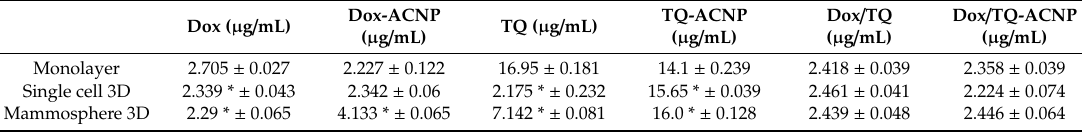
Figure 6. Graphical representation of IC50 data for the three culture conditions upon various treatments for 10 days. * p < 0.05 compared to monolayer. Table 1. IC 50 data for the three culture conditions upon various treatment for 10 days.